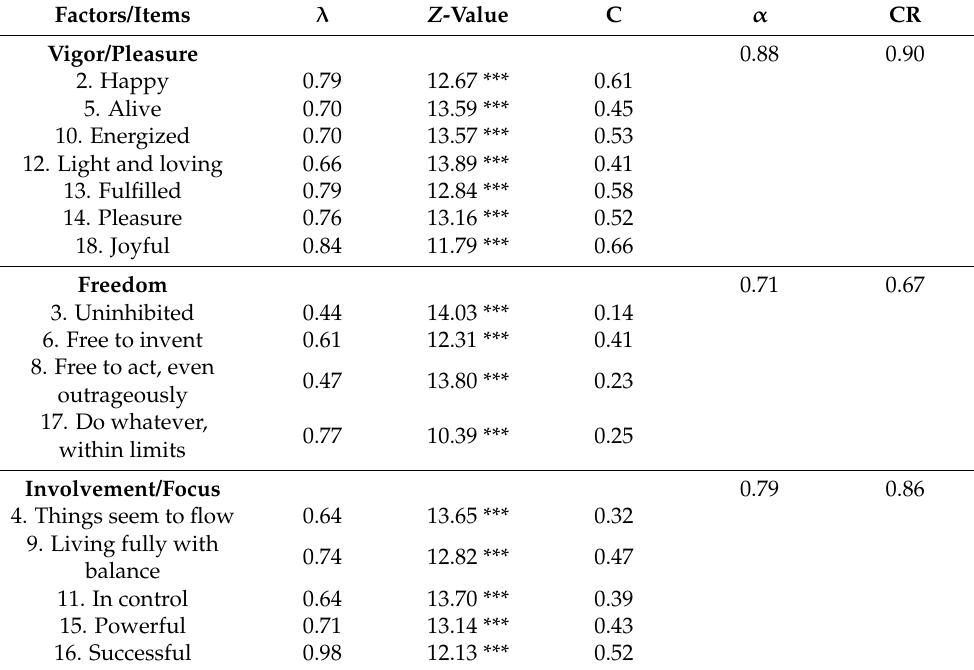
Table 3. Factor loadings, Z-values, Communalities, Cronbach alpha and Composite reliability of the SAI-Rp model at 3 factors with 16